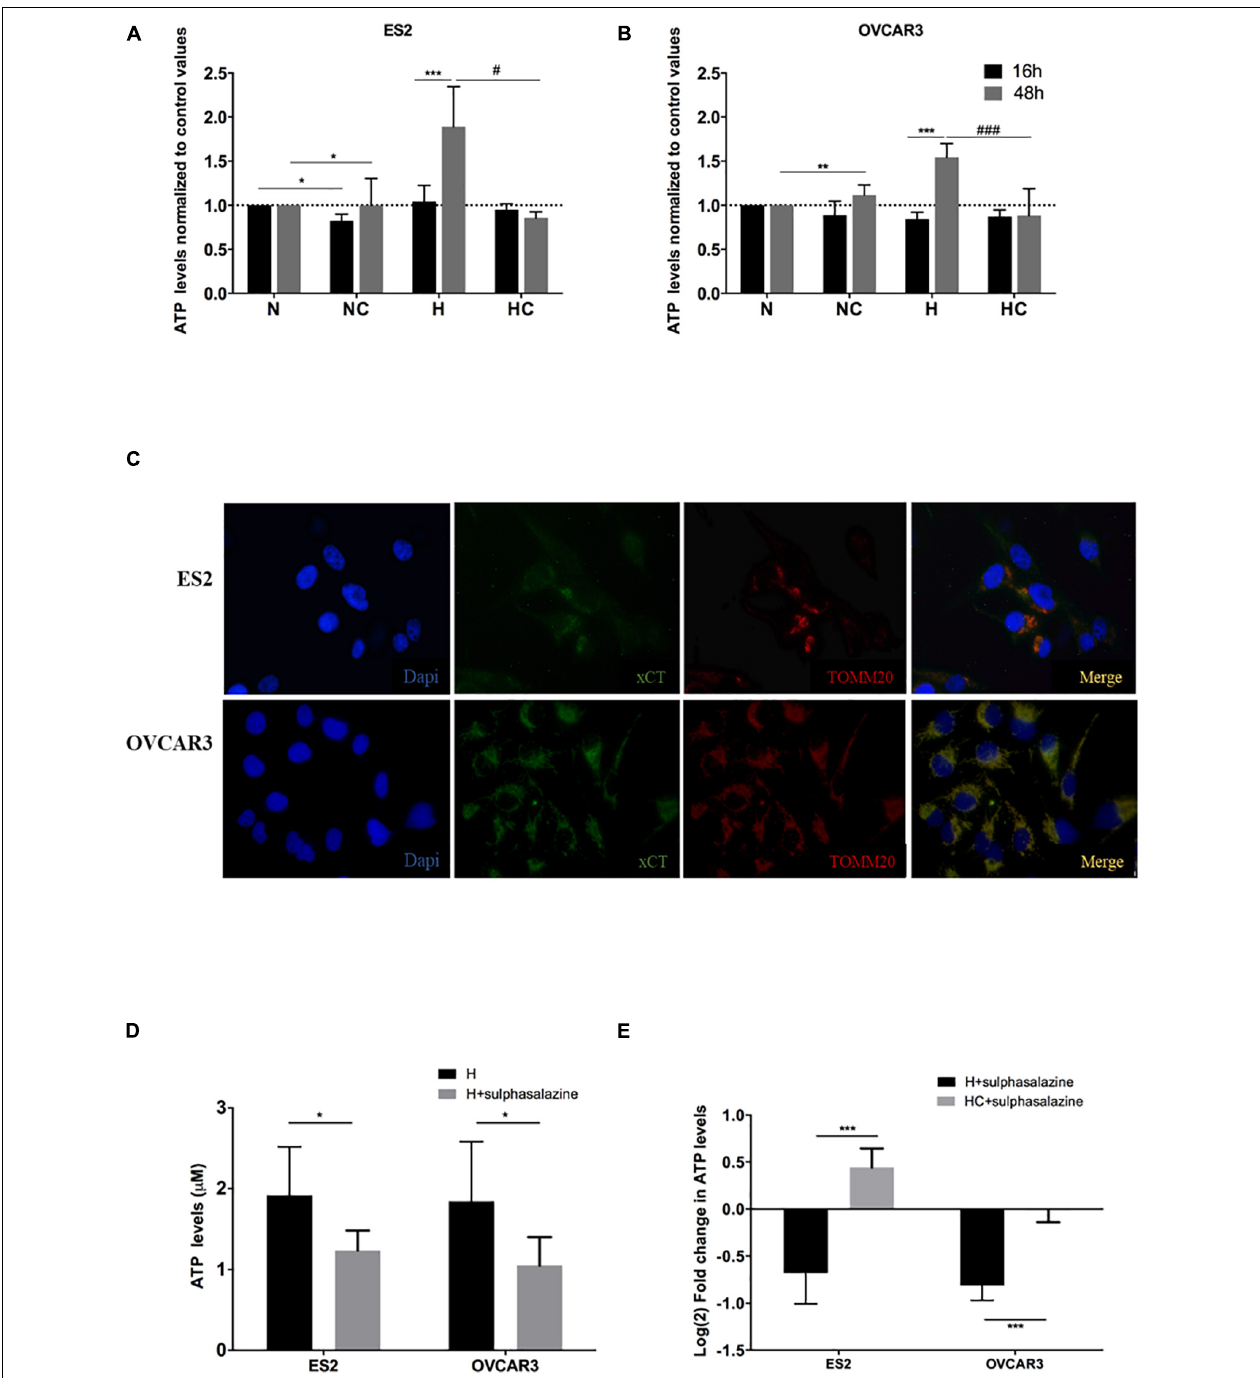
FIGURE 1 | xCT transporter localizes in ovarian cancer cells’ mitochondria and its inhibition impairs ATP production under hypoxia, which is further rescued by cysteine. ATP levels normalized to control values (normoxia without cysteine supplementation) for 16 h and 48 h of experimental conditions for (A) ES2 cells and (B) OVCAR3 cells. The differences among treatments are pointed in the figure (one-way ANOVA with post hoc Tukey tests. For ES2, n = 6 for all treatments for 16 h of experimental conditions and n = 3 for 48 h of experimental conditions. For OVCAR3, n = 6 for all experimental conditions). (C) Immunofluorescence analysis for the xCT transporter and TOMM20 under control conditions (normoxia) for ES2 and OVCAR3 cells ( n = 3). (D) ATP levels for 48 h of experimental conditions for ES2 and OVCAR3 cells under hypoxia and in the presence of the xCT inhibitor, sulfasalazine. (E) ATP levels for 48 h of experimental conditions for ES2 and OVCAR3 cells under hypoxia and in the presence of sulfasalazine and cysteine. The values were normalized to the respective control and log 2 fold change was calculated. The differences among treatments are pointed in panels (D,E) (independent-samples t -test; n = 6 for all experimental conditions and for both cell lines). N, normoxia; NC, normoxia with cysteine; H, hypoxia; HC, hypoxia with cysteine. Results are shown as mean ± SD. * / # p < 0.05, ** / ## p < 0.01, *** / ### p < 0.001.